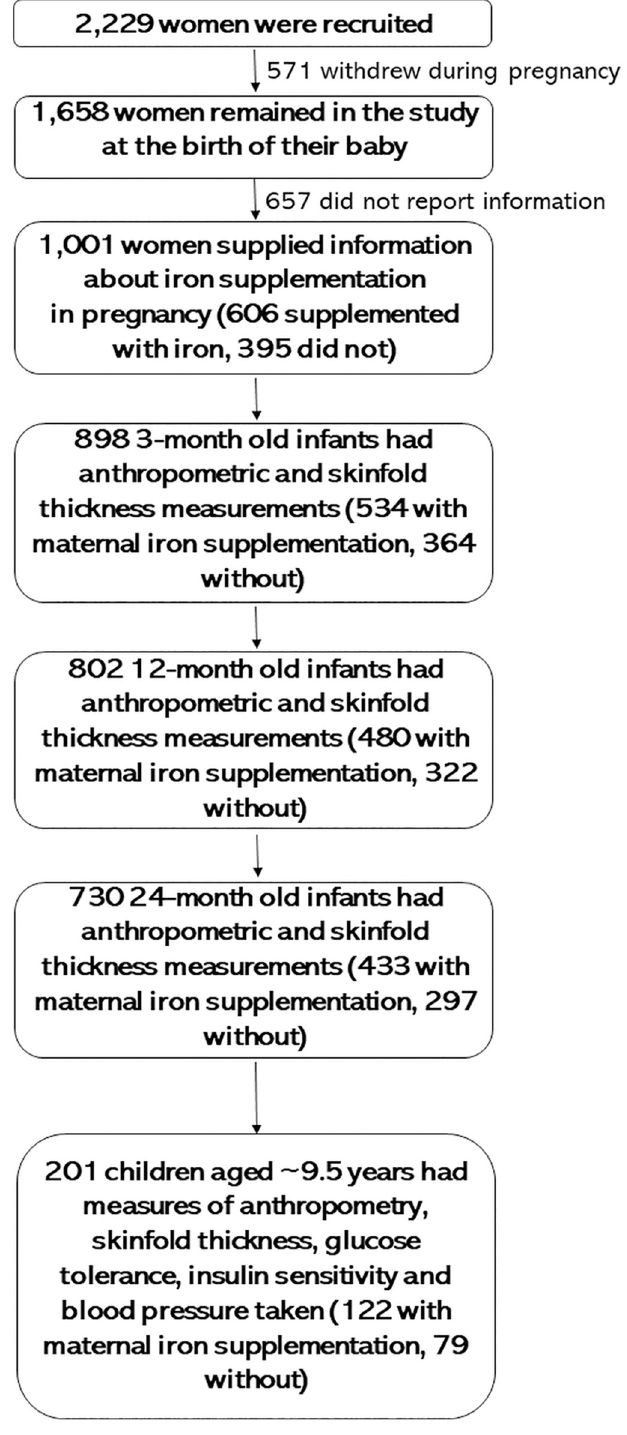
Fig 1. A schematic representation of this study. The maximal numbers of women included at each stage of the study are shown, as well as outlines of what was assessed at each age.